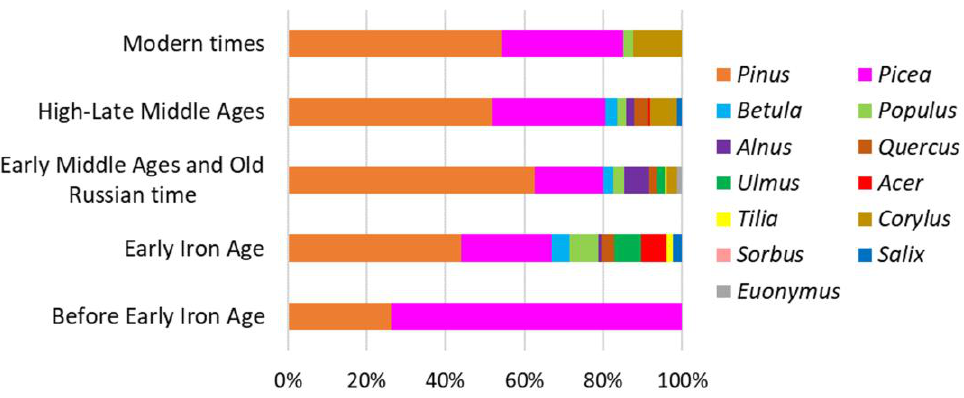
Figure 8. Proportions of charcoals of different taxa across study areas by each historical period. The proportion of deciduous trees was greatest in the Early Iron Age: “pioneer” deciduous taxa accounted for 12.6% and nemoral broad-leaved taxa for 18.3%; here Ulmus and Acer had the highest proportion among all time periods. In the Early Medieval and Old Russian periods, the proportion of “pioneer” deciduous taxa was 11.6% with Alnus dominating; nemoral broad-leaved taxa accounted for 7.2%. In the High-Late Middle Ages, the proportion of “pioneer” deciduous taxa was 7.1%; nemoral broad-leaved taxa constituted 11%, with Ulmus and Tilia disappearing since that time and the proportion of Corylus increasing. In the Modern period, the proportion of “pioneer” deciduous taxa was 2.5% (only Populus was found), while the proportion of nemoral broad-leaved taxa was 12.3%, represented by Corylus